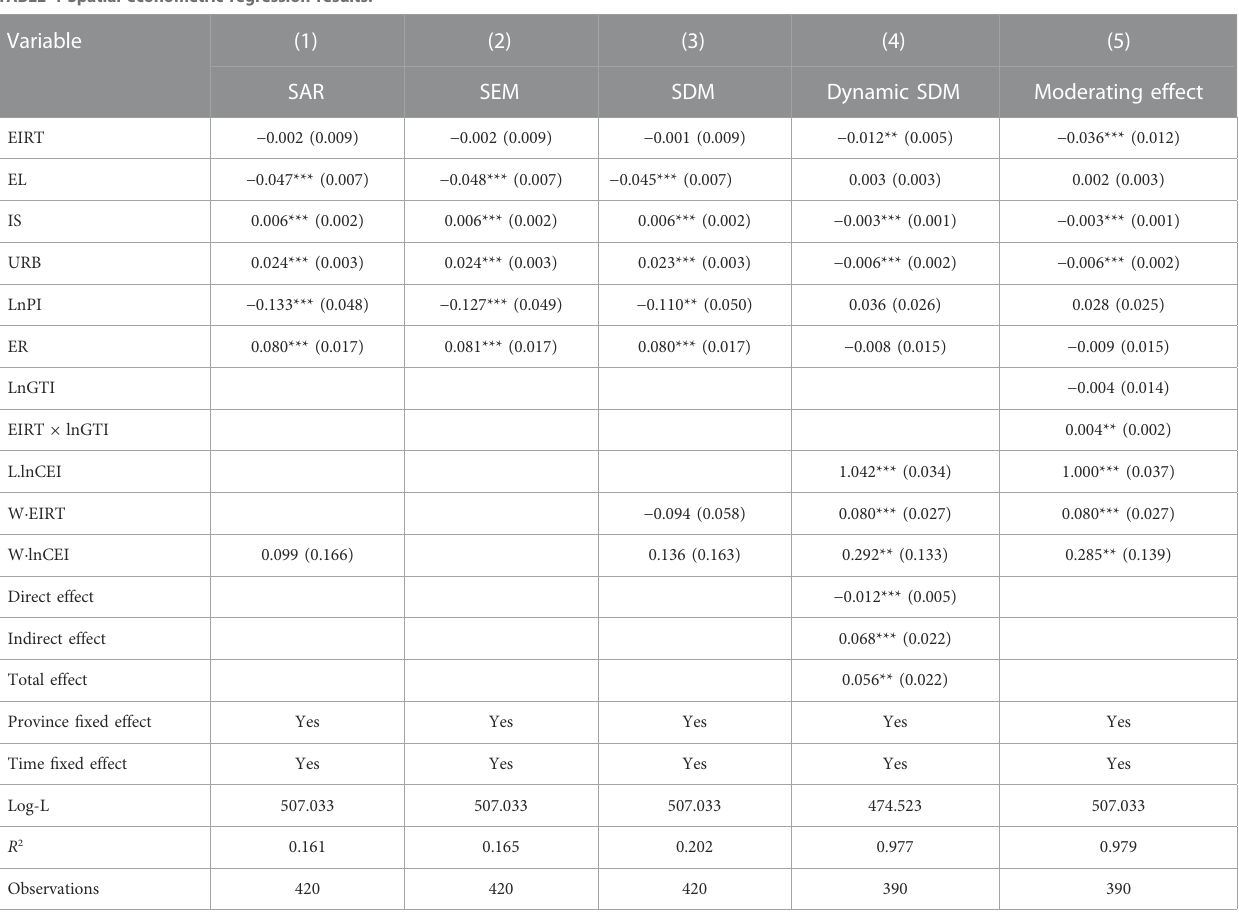
TABLE 4 Spatial econometric regression results.